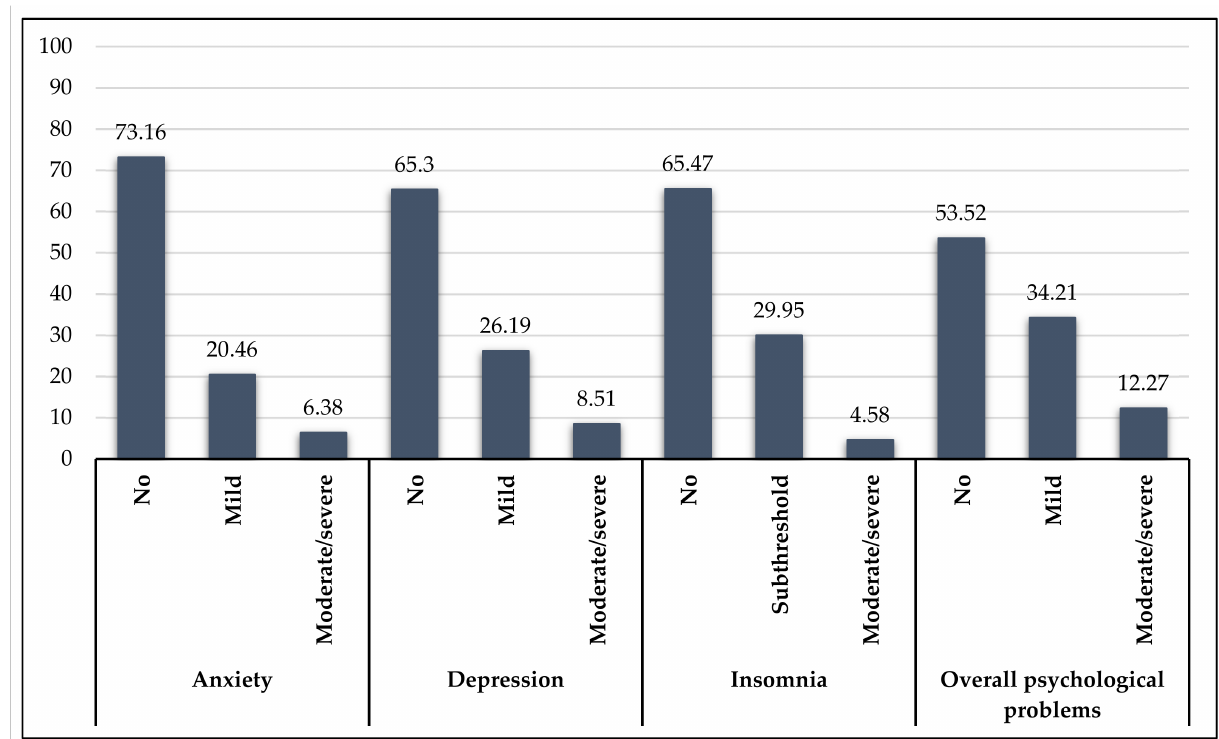
Figure 1. Severity categories of depression, anxiety, and insomnia and overall psychological